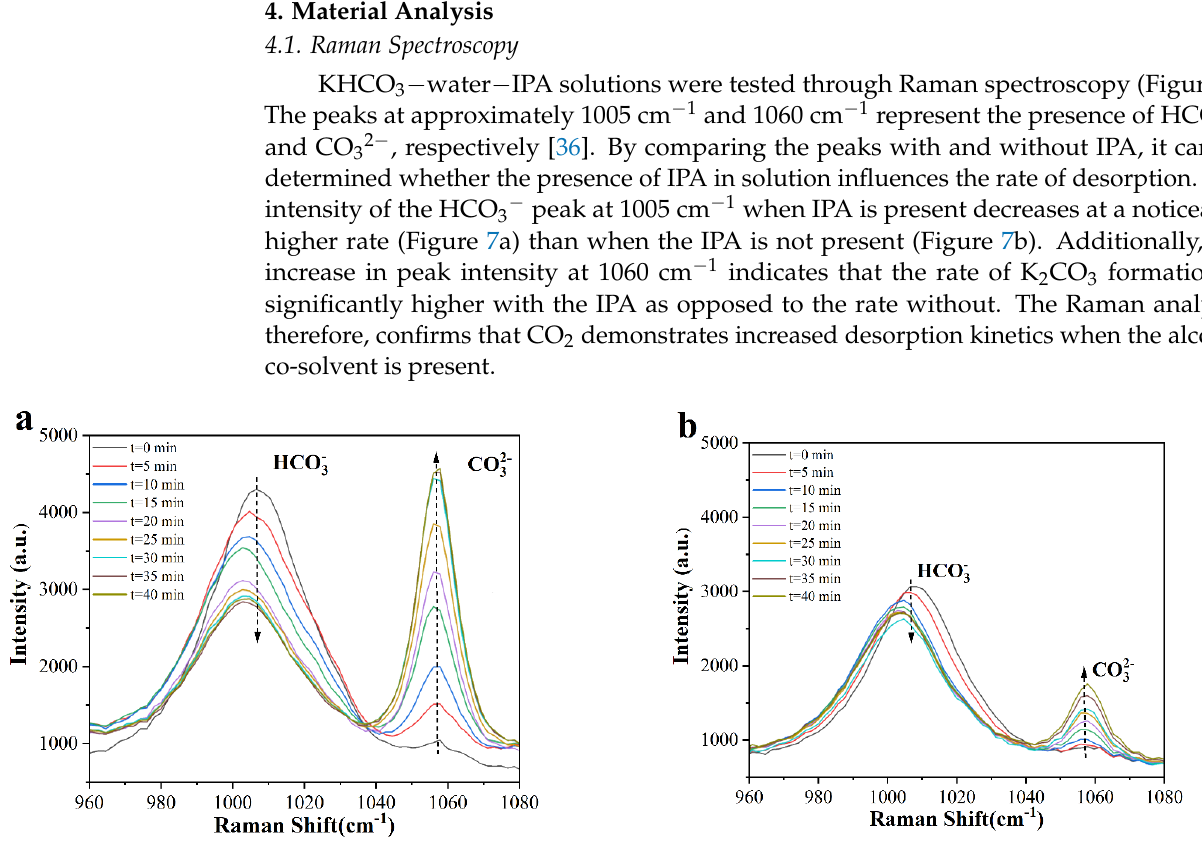
Figure 7. Raman spectra of CO 2 desorption. Measurements were taken at five-minute intervals from time 0 min to 40 min. ( a ) KHCO 3 − water − IPA solution (36 wt % IPA). ( b ) KHCO 3 − water solution. Based on the Raman results, a possible evolution mechanism is proposed in Figure